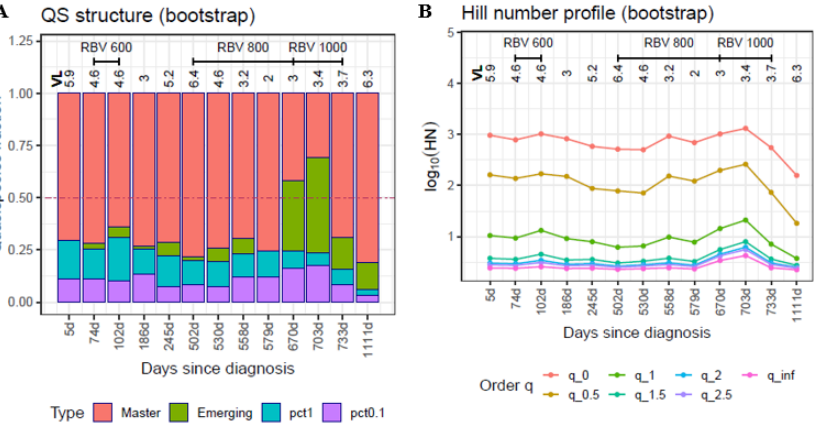
Figure 4. UPGMA tree of the master haplotypes based on raw nucleotide distances ( A ), and quasispecies tree based on the Da population distances ( B ) taking the top 50 haplotypes in each sample. Each sample is labeled as days since the diagnosis.